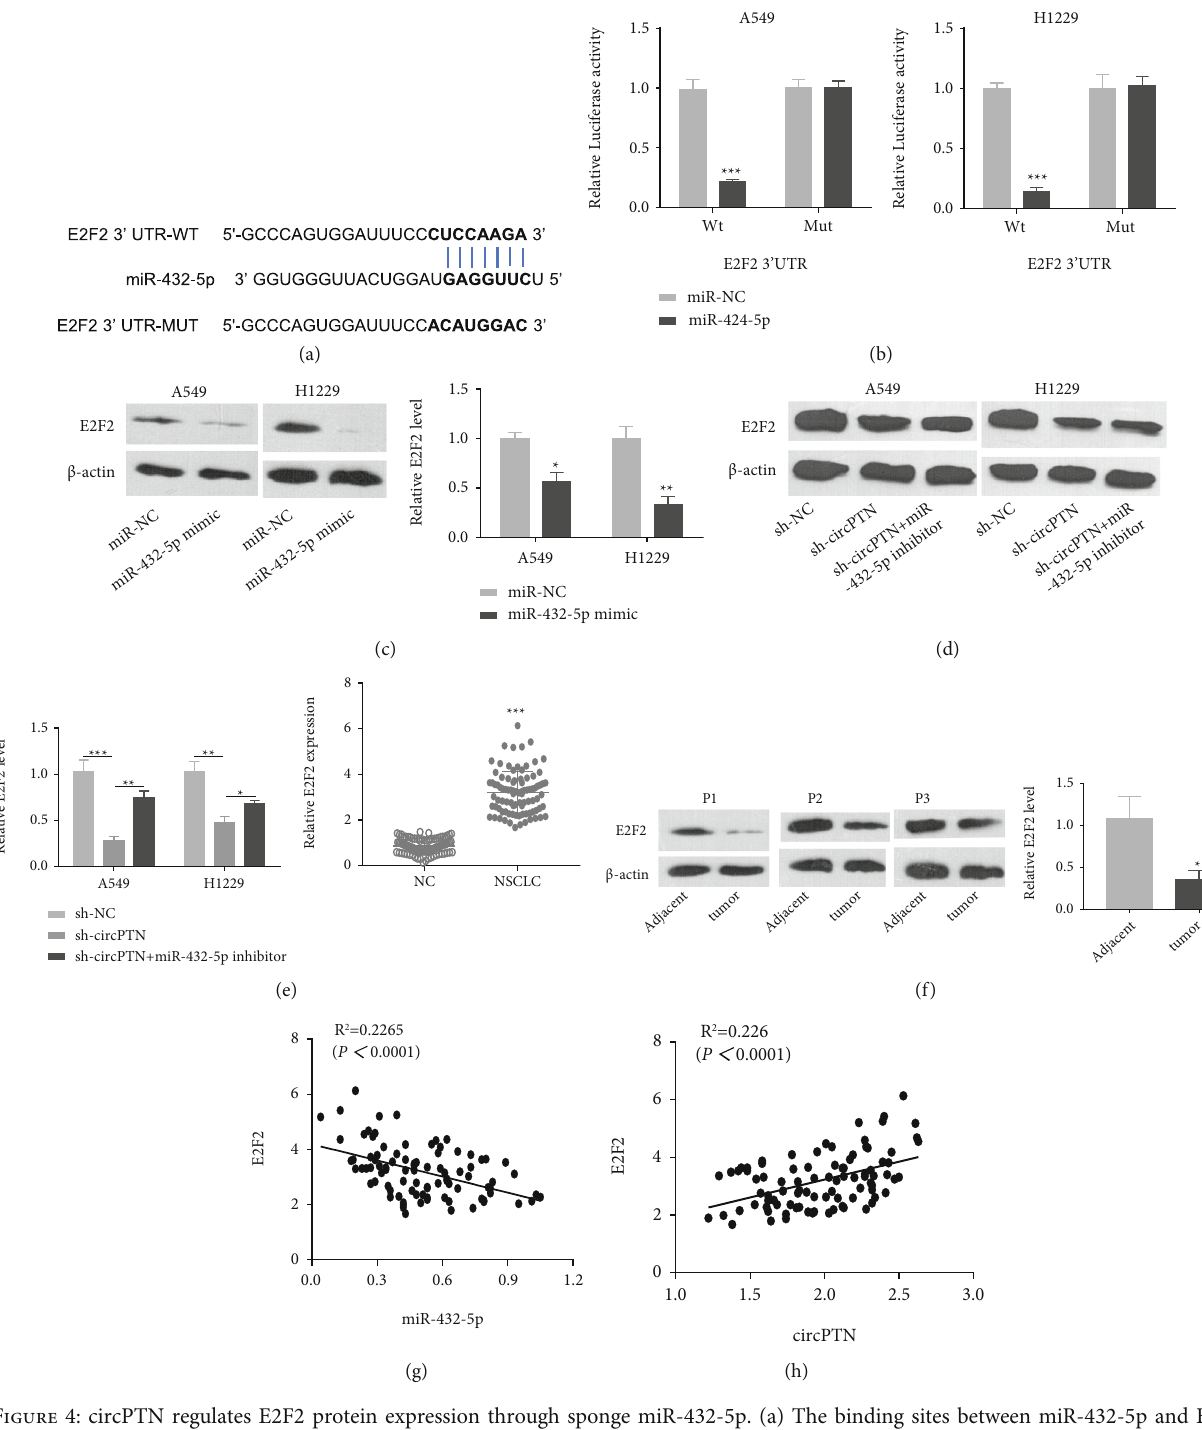
Figure 4: circPTN regulates E2F2 protein expression through sponge miR-432-5p. (a) The binding sites between miR-432-5p and E2F2 mRNA were predicted by TargetScan. (b) Dual-luciferase reporter assay in A549 and H1229 cells using WT reporter (with wildtype binding sites) or MUT reporter (with mutated binding sites) in the presence of miR-NC or miR-432-5p mimic. (c) The protein level of E2F2 in A549 and H1229 cells upon miR-432-5p mimic transfection was detected by WB. (d) E2F2 protein levels in A549 and H1229 cells transfected with sh-NC, sh-circTPN, or sh-circTPN and miR-432-5p inhibitor were determined by WB. (e) qRT-PCR was used to detect the expression level of E2F2 in 90 pairs of NSCLC tissues and adjacent normal tissues. (f) The protein levels of E2F2 protein in three pairs of NSCLC tissues and corresponding adjacent tissues were determined by WB. (g) The correlation between the expression levels of E2F2 and miR-432-5p in NSCLC tissues. (h) The correlation between the expression levels of E2F2 and circPTN in NSCLC tissues. * P < 0 : 05 ; ** P < 0 : 01 ; and *** P < 0 : 001